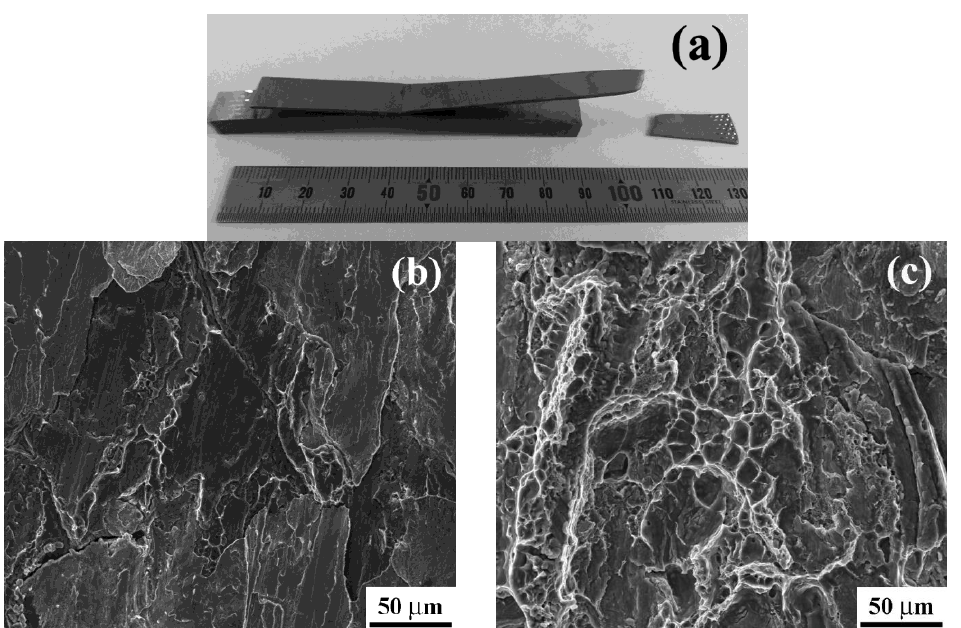
Figure 7. Fractural joint for ( a ) process III and the fractural surfaces of the welds for ( b , c ) processes I I and IV.